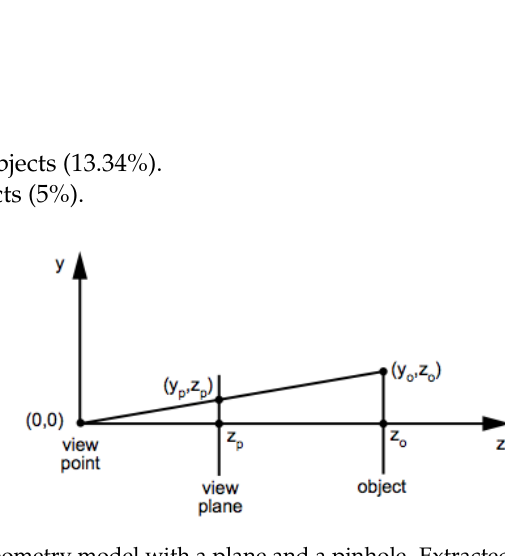
Figure 3. Raycasting geometry model with a plane and a pinhole. Extracted from [11] and reproduced with permission from Prof.